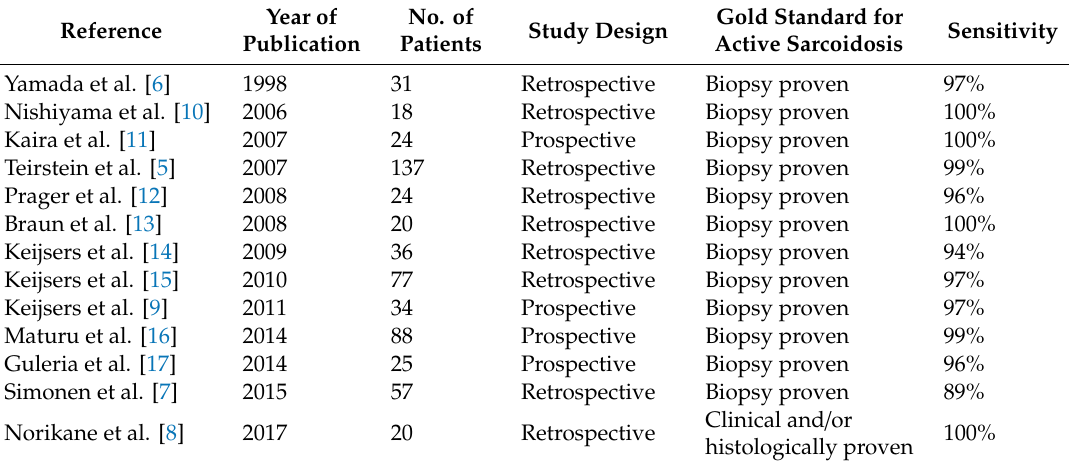
Table 1. Sensitivity of fluorodeoxyglucose (FDG) positron emission tomography (PET) / CT in assessing sarcoidosis